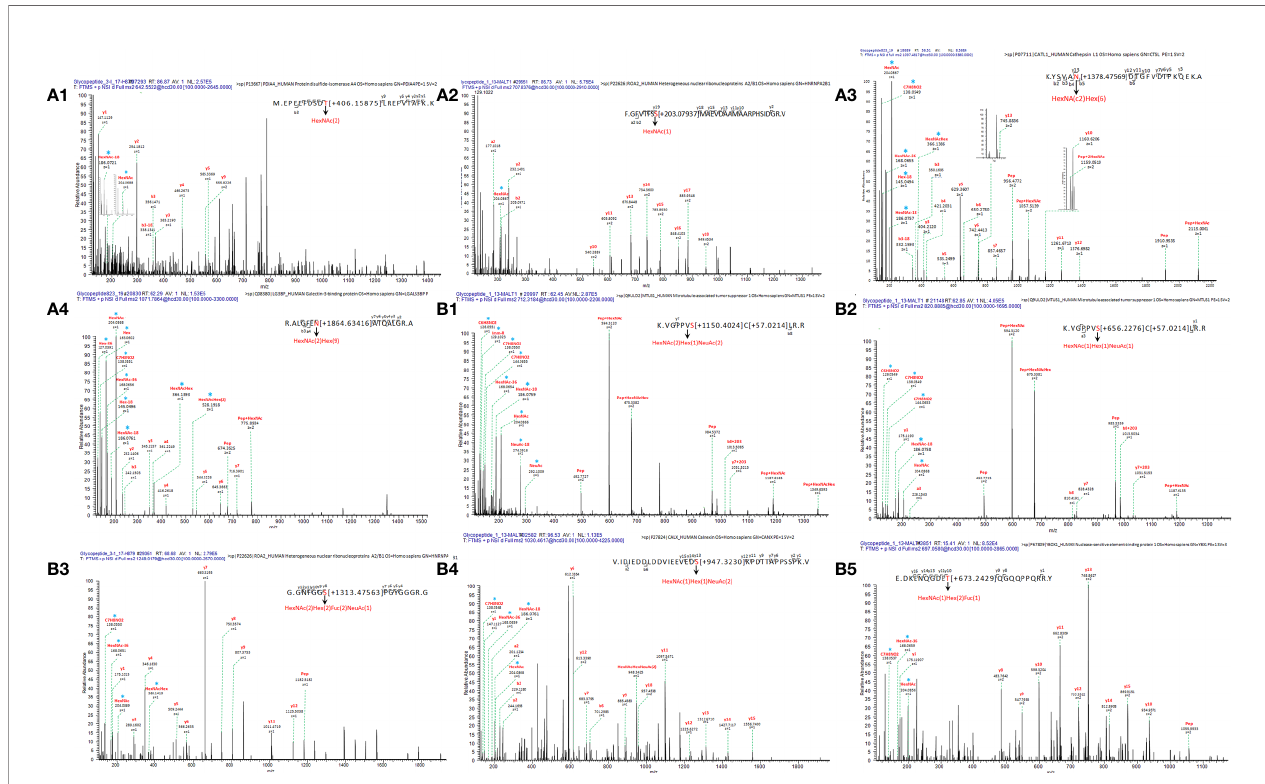
FIGURE 3 | Linear glycan sequence shown by HCD MS/MS fragmentation of the ions on a QE-HF. The correspondence of ion, glycopeptide sequences in the mass spectrum: (A1) m/z 642.5522 [z=4], M.EPEEFDSDT[+406.15875]LREFVTAFK. K, protein PDIA4; (A2) m/z 707.8376 [z=4], F.GFVTFSS[+203.07937] MAEVDAAMAARPHSIDGR. V, protein HNRNPA2B1; (A3) m/z 1249.0179[z=2], K.YSVAN[+1378.47569]DTGFVDIPKQEK. A, protein CTSL; (A4) m/z 1071.7864 [z=3], R.ALGFEN[+1864.63416]ATQALGR. A, protein LGALS3BP; (B1) m/z 712.3184[z=3], K.VGPPVS[+1150.4024]C[+57.0214]LR. R, protein